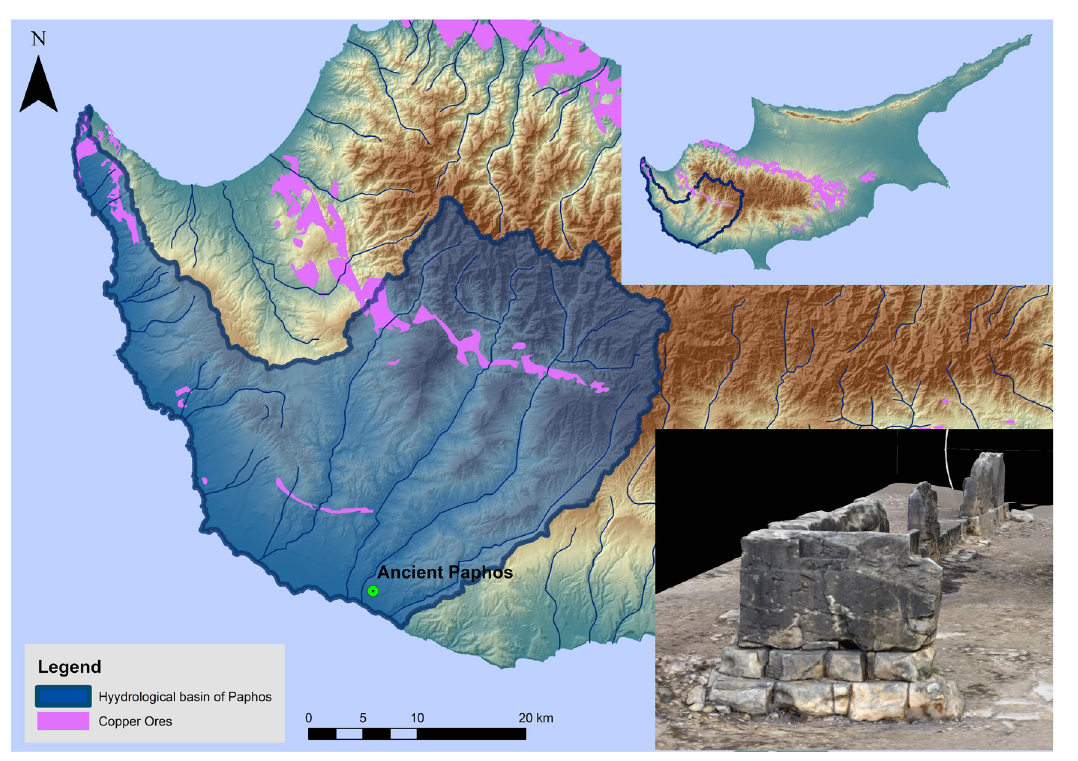
Figure 1. The Paphos hydrological basin (catchment). Digital geological data from Cyprus Geological Survey. Composite illust- ration with 3D view of the LC temenos (south corner). Drafted by A. Agapiou